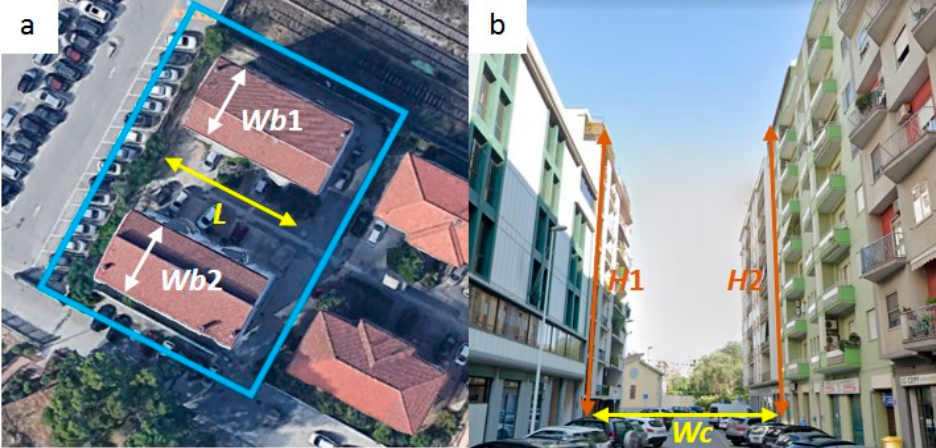
Figure 1. UCPs definition. ( a ) Planar view of a canyon, where the elements of interest are framed in blue. L indicates the canyon length, and Wb 1 and Wb 2 the width of the building on the side of the canyon. ( b ) Frontal view of a canyon, and representation of the canyon width ( Wc ), and buildings heights on the sides ( H 1 and H 2). Source: Google Earth.